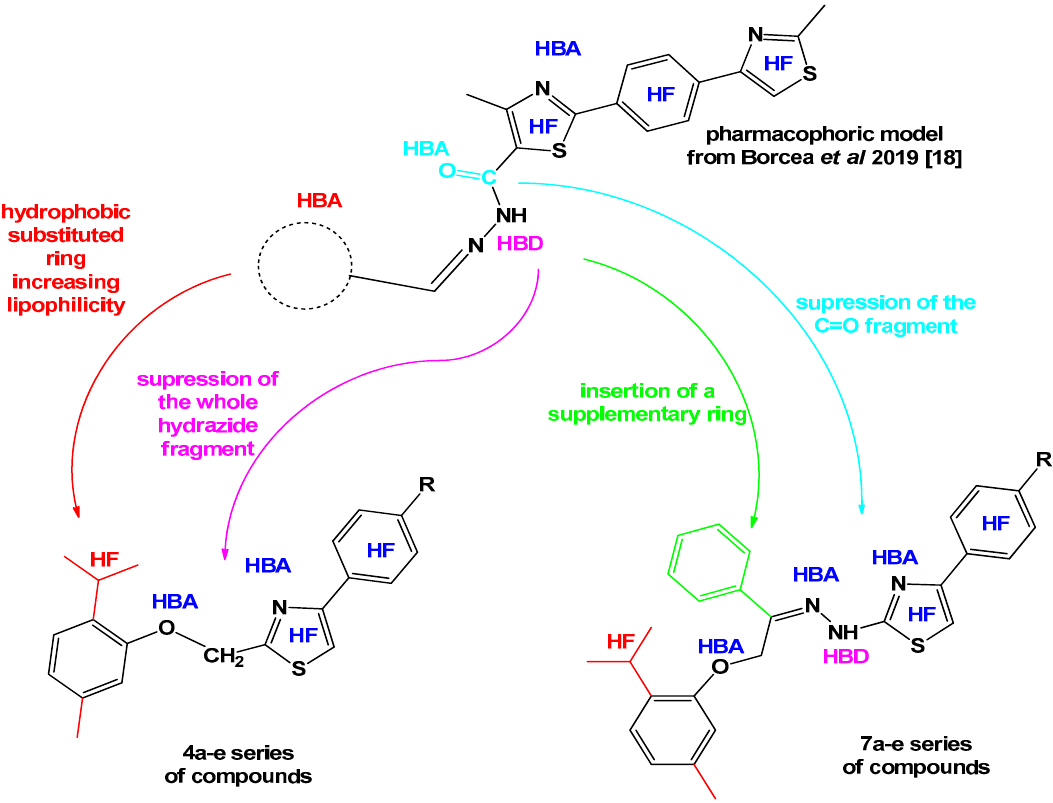
Figure 1. Rational design of the titled 4-substituted thiazole derivatives (HF–hydrophobic feature; HBA–hydrogen bond acceptor; HBD–hydrogen bond donor).